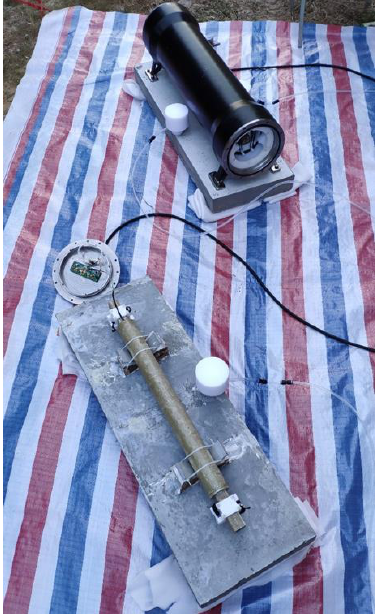
Figure 11. Site layout of the functional comparison test.